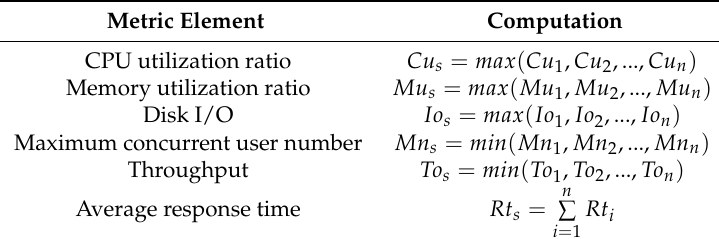
Figure 1. The series relation system. Table 3. The computation of the series relation